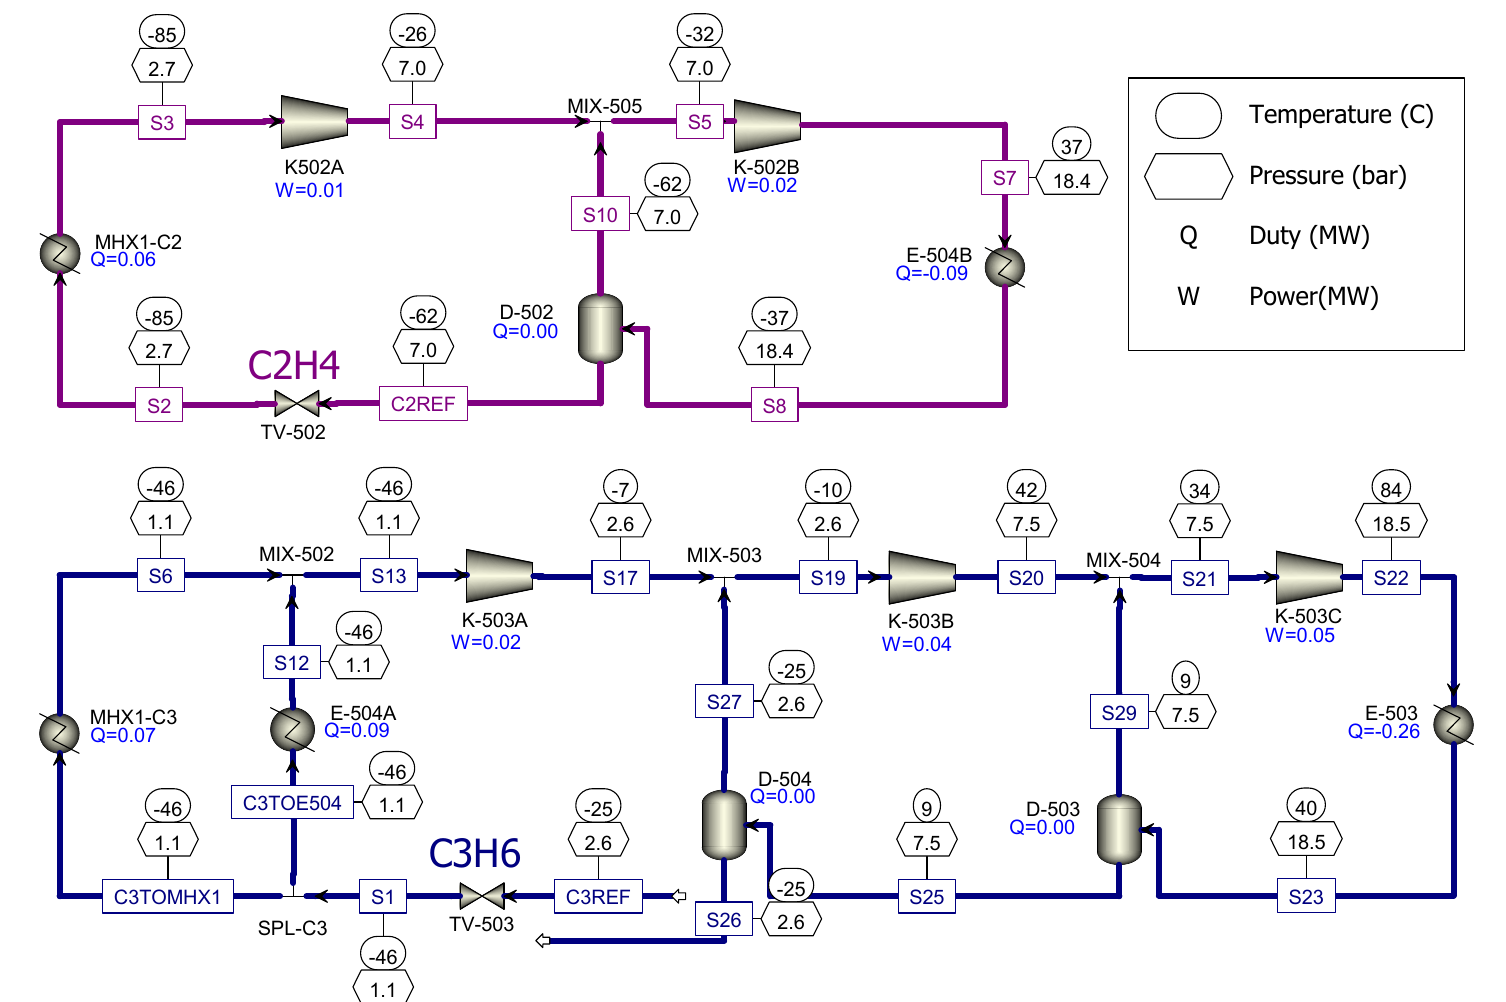
Figure 12. Process simulation of the external refrigeration system of the RSV distillation configuration implemented in Aspen Plus software. Reproduced with permission from Penteado, Ph.D. Thesis, TUB, 2021